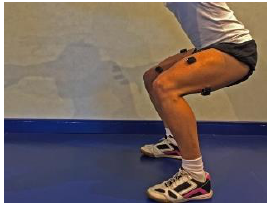
Figure 3. Squat exercise.